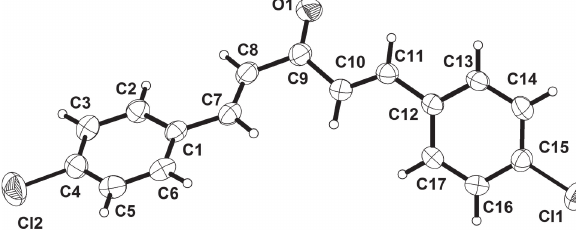
Table 1: Data collection and handling.